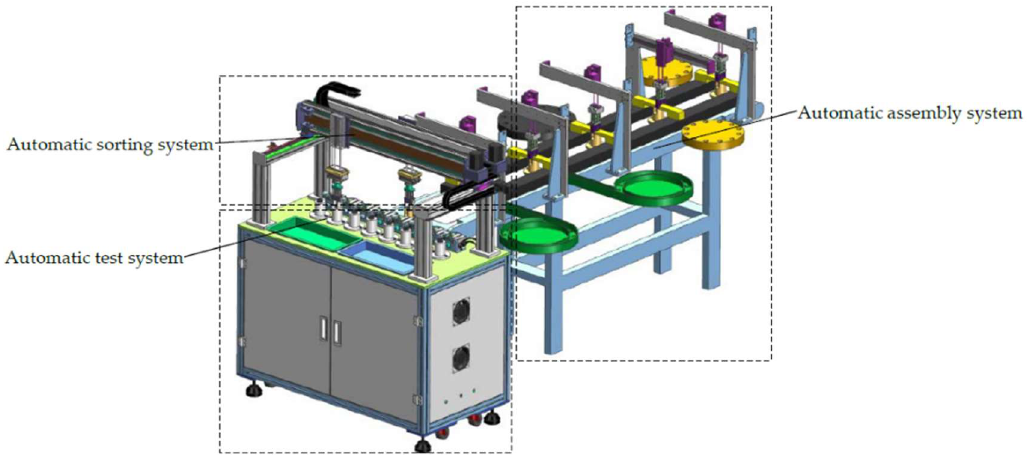
Figure 3. General structure of the automatic production line.